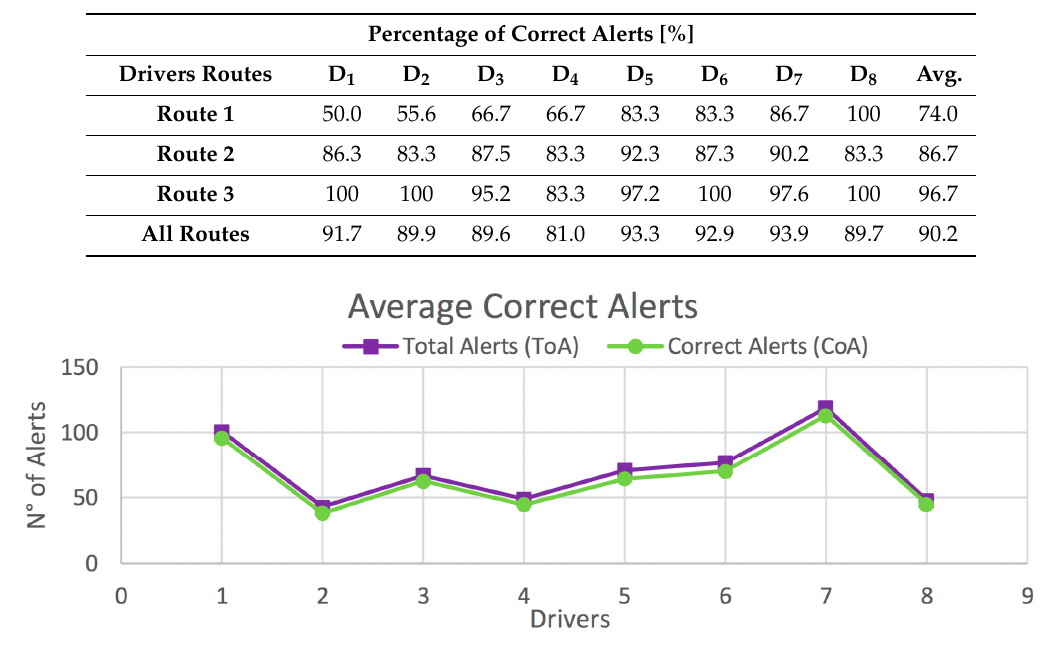
Figure 14. Average total correct alerts on all routes for all vehicles ( V 1 & V 2 ). Table 5. Percentage of correct alerts on all routes for all vehicles ( V 1 & V 2 ). Percentage of Correct Alerts [%]